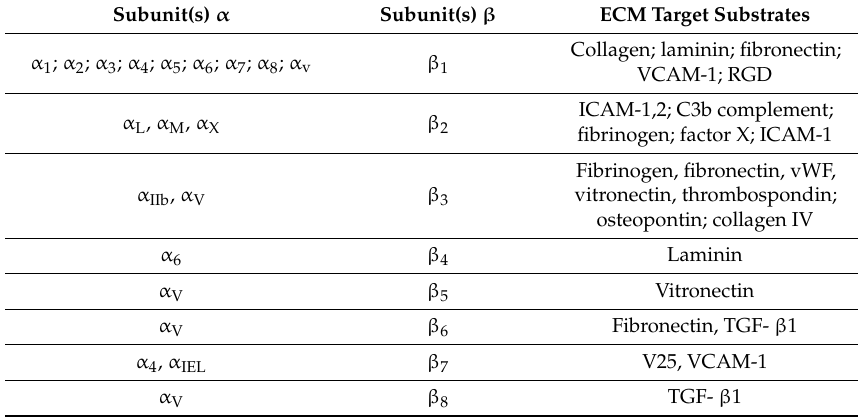
Table 1. Integrins subunits and their specific extracellular matrix (ECM) proteins